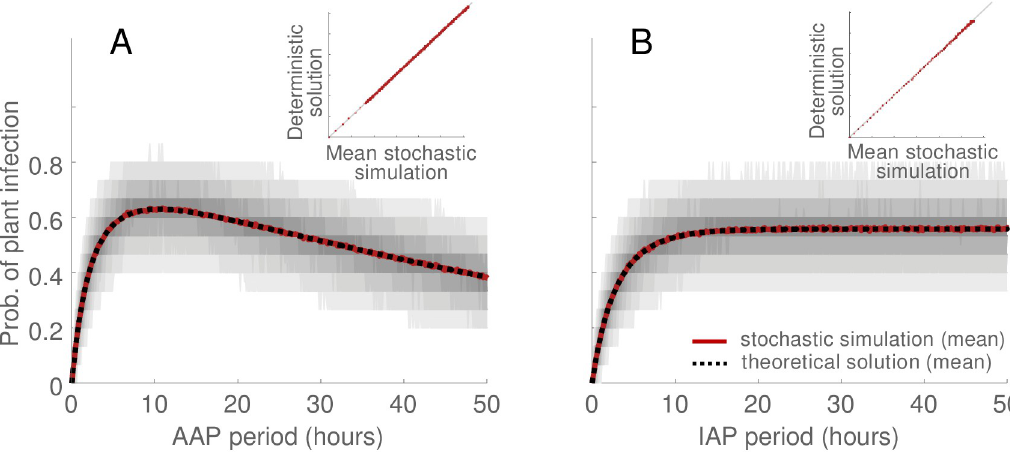
Fig 2. Stochastic modelling of access period assays without molecular diagnostics. In A: acquisition response curve, in B: inoculation response curve. In A-B gray curves indicate the 2.5th-97.5th percentile range of simulations (i.e., demarcating 95% of simulations with darker shades of gray for percentile bands near the median). Solid ruby curves indicate the mean of simulations. Dotted black curves show the mathematical solution (i.e., Eq 5 in A, and Eq 6 in B). Figure inset shows the correspondence between computer simulations and mathematical solutions. Computer simulation involved reproducing the access period experiments using event-based stochastic simulation, with the epidemiological parameters assigned the values listed in the ‘True value’ column of Table 2. In both A and B 1000 simulations were initiated with cohorts of 50 virus-free adult vectors placed on virus-infected plants, with 15 plant/insect cohort replicates per simulation. The fixed access period duration was 24 hours (i.e., the inoculation access period in A , and the acquisition access period in B , was 24 hours